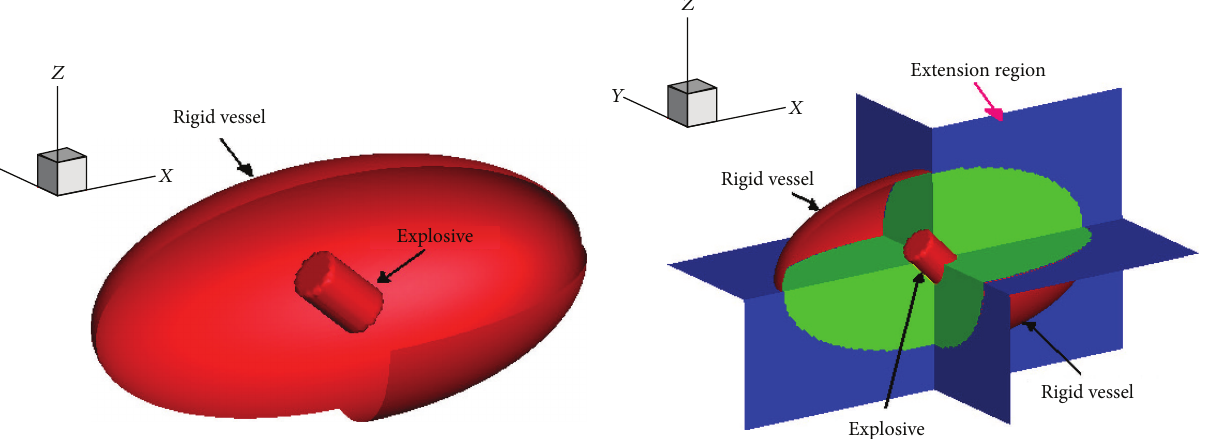
Figure 14: Schematics of computational region (Case 6).